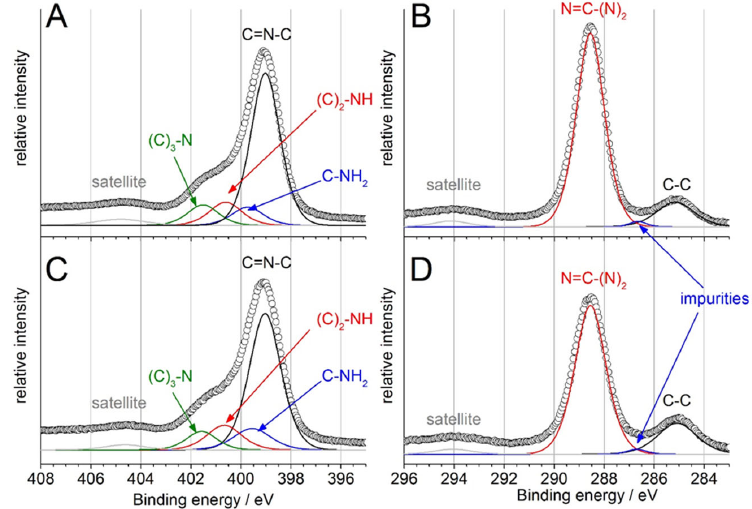
Figure 3. X-ray photoelectron spectroscopy (XPS) investigation on g-CN ( A , B ) and g-CN-HT ( C , D ). N 1s core-level spectra for g-CN ( A ) and g-CN-HT ( C ). C 1s core-level spectra for g-CN ( B ) and g-CN-HT ( D ).